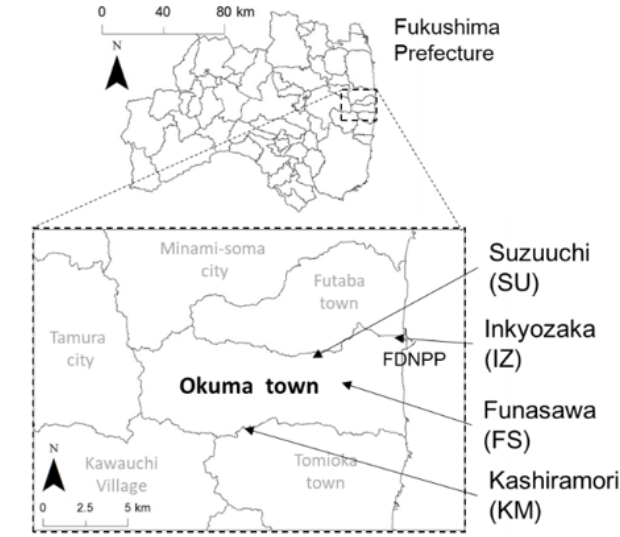
Figure 1. Location of study sites in Fukushima Prefecture and in Okuma